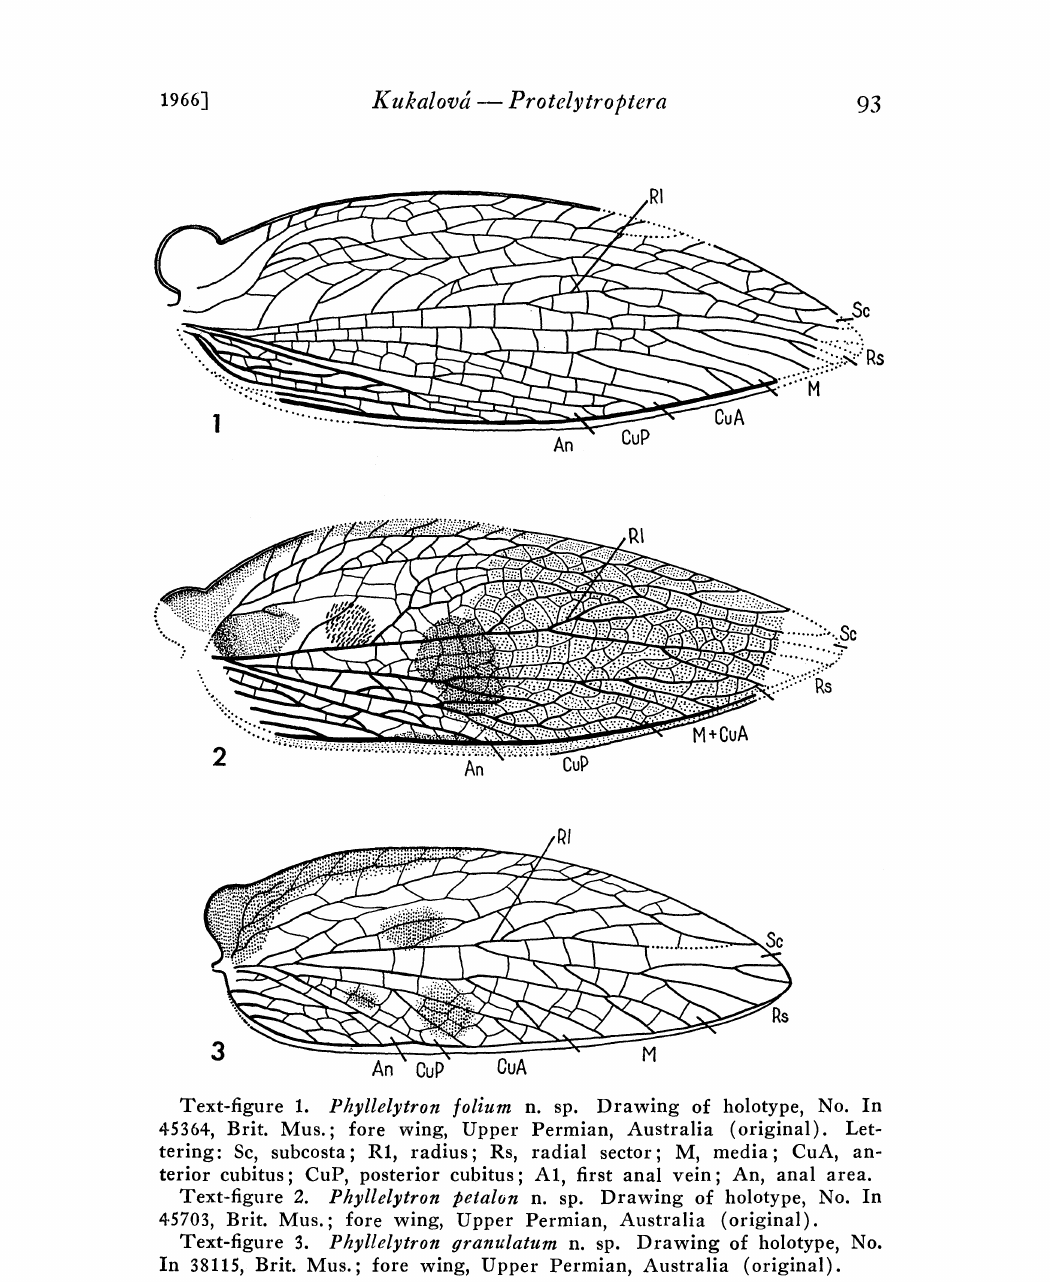
Text-figure 1. Phyllelytron folium n. sp. Drawing of holotype, No. In 45364, Brit. Mus.; fore wing, Upper Permian, Australia (original). Let- tering" Sc, subcosta; R1, radius; Rs, radial sector; M, media; CuA, an- terior cubitus; CuP, posterior cubitus; A1, first anal vein; An, anal area. Text-figure 2. Phyllelytron etalon n. sp. Drawing of holotype, No. In 45703, Brit. Mus.; fore wing, Upper Permian, Australia (original). Text-figure 3. Phyllelytron granulatum n. sp. Drawing of holotype, No. In 38115, Brit. Mus.; fore wing, Upper Permian, Australia